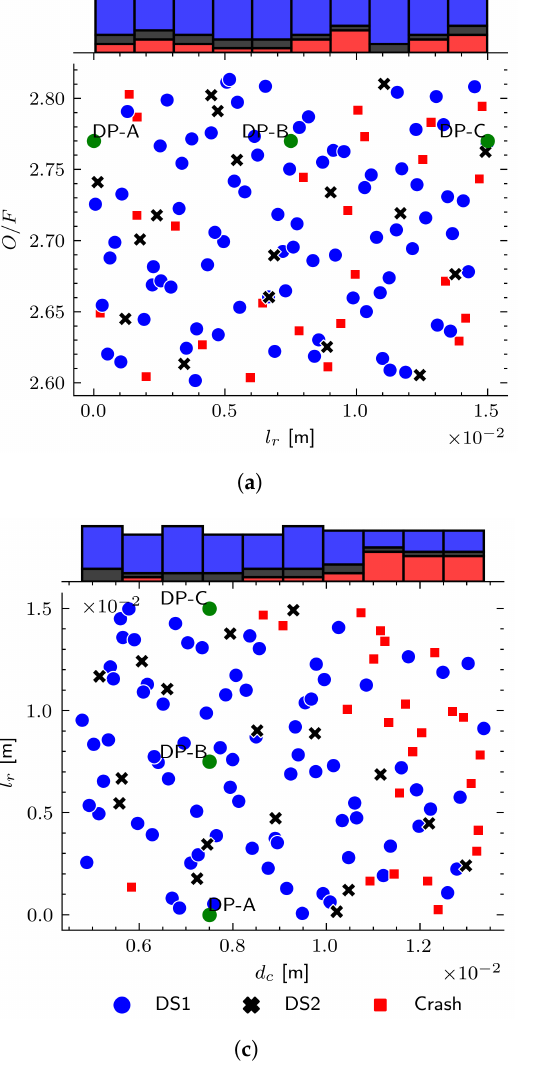
Figure 3. Joint plots of the points from the DOE projected in two-dimensional subspaces and consumption statistics graph. Colored histograms of the abscissa are displayed on top. ( a ) l r vs. O / F , ( b ) O / F vs. d c , ( c ) d c vs. l r , and ( d ) CPU hours consumed vs. number of tetrahedral cells in mesh used. The locations of DP-A, DP-B, and DP-C introduced later in Section 5, have been included as green dots for reference in ( a , c